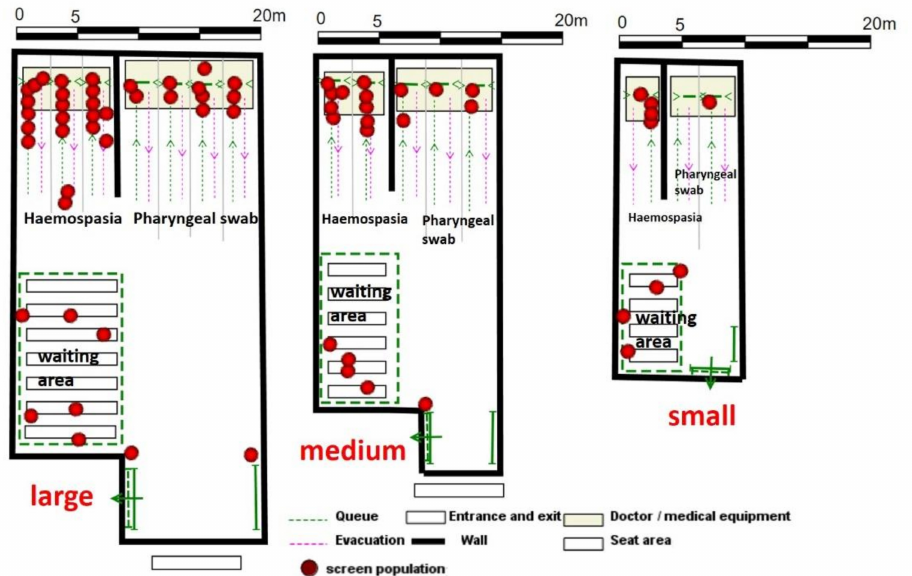
Figure 6. Schematic diagram of Community virus testing facilities spatial distribution